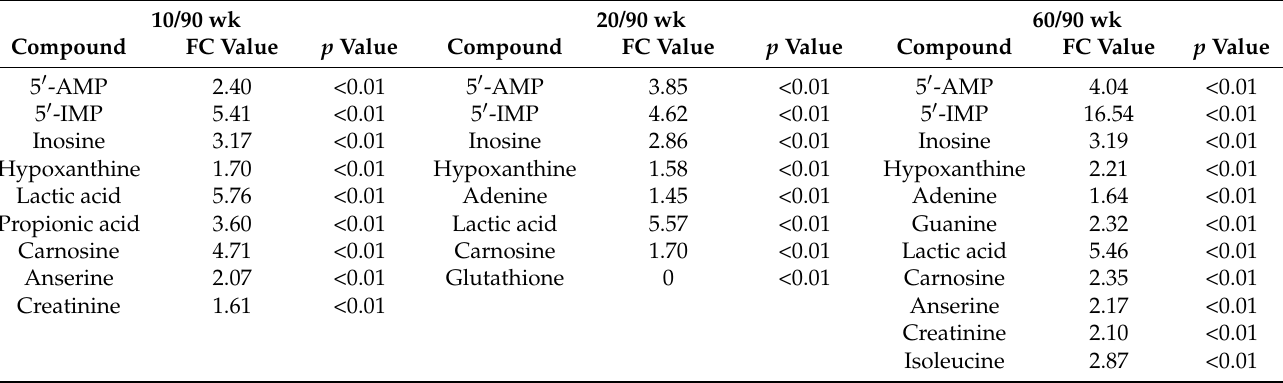
Table 1. The fold change (FC) and p value for compounds with VIP ≥ 1 in three